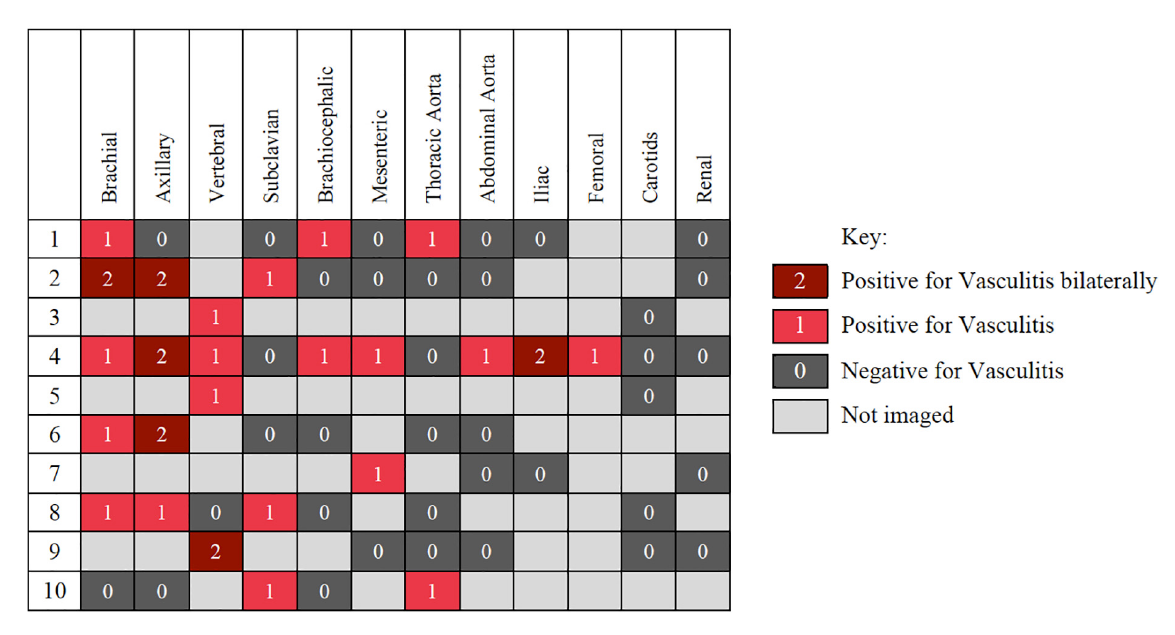
FIGURE2 Distribution of disease involvement in the 10 patient with large vessels vasculitis detected on computed tomography angiography (CT-A), magnetic resonance angiography (MR-A), and ultrasound (US).